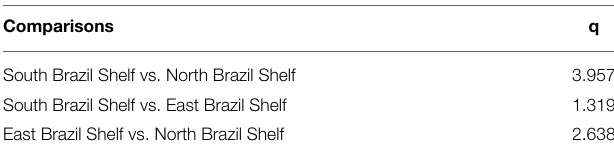
TABLE 3 | Multiple comparison Tukey test for differences among medians for duration of spawning season (SE = standard error = 3.791; q = standardized difference; q 0 . 05 , 3 =